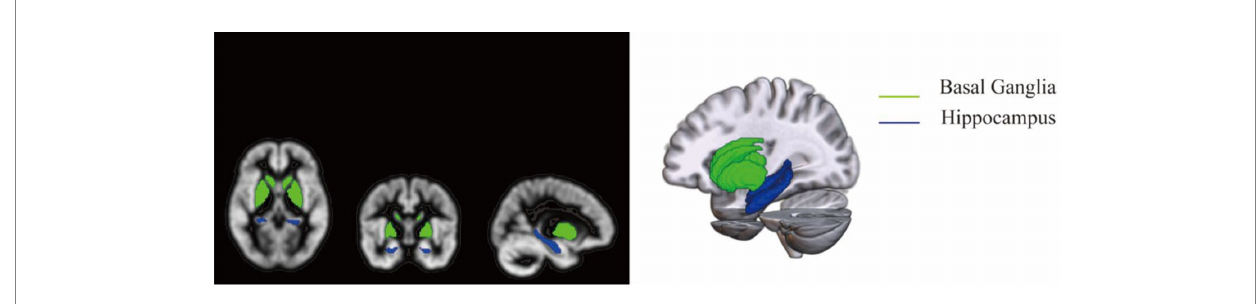
FIGURE 1 Regions of interest for extracted